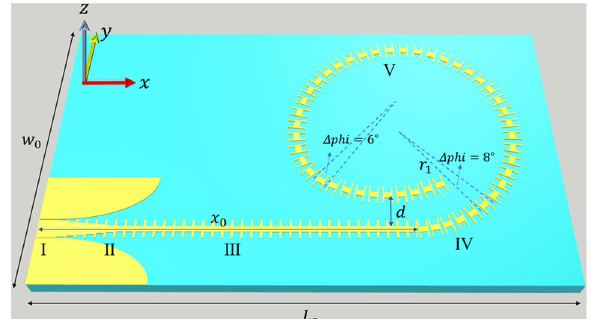
Figure 2. High-order OAM single-port antenna structure based on H-shaped periodic